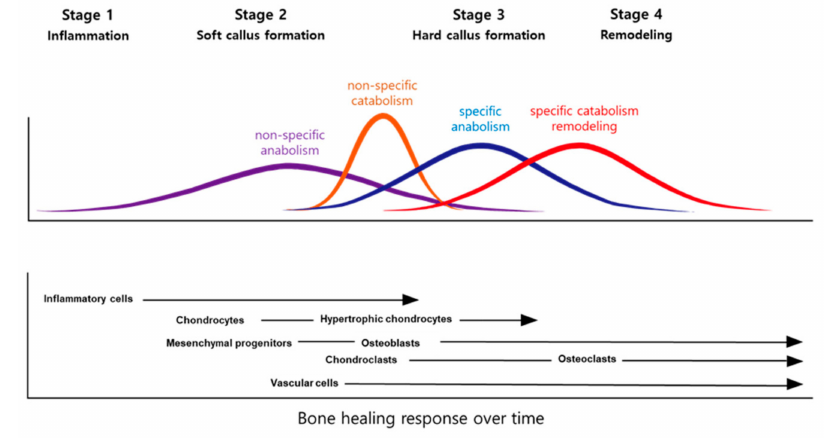
Figure 1. Models of the fracture healing